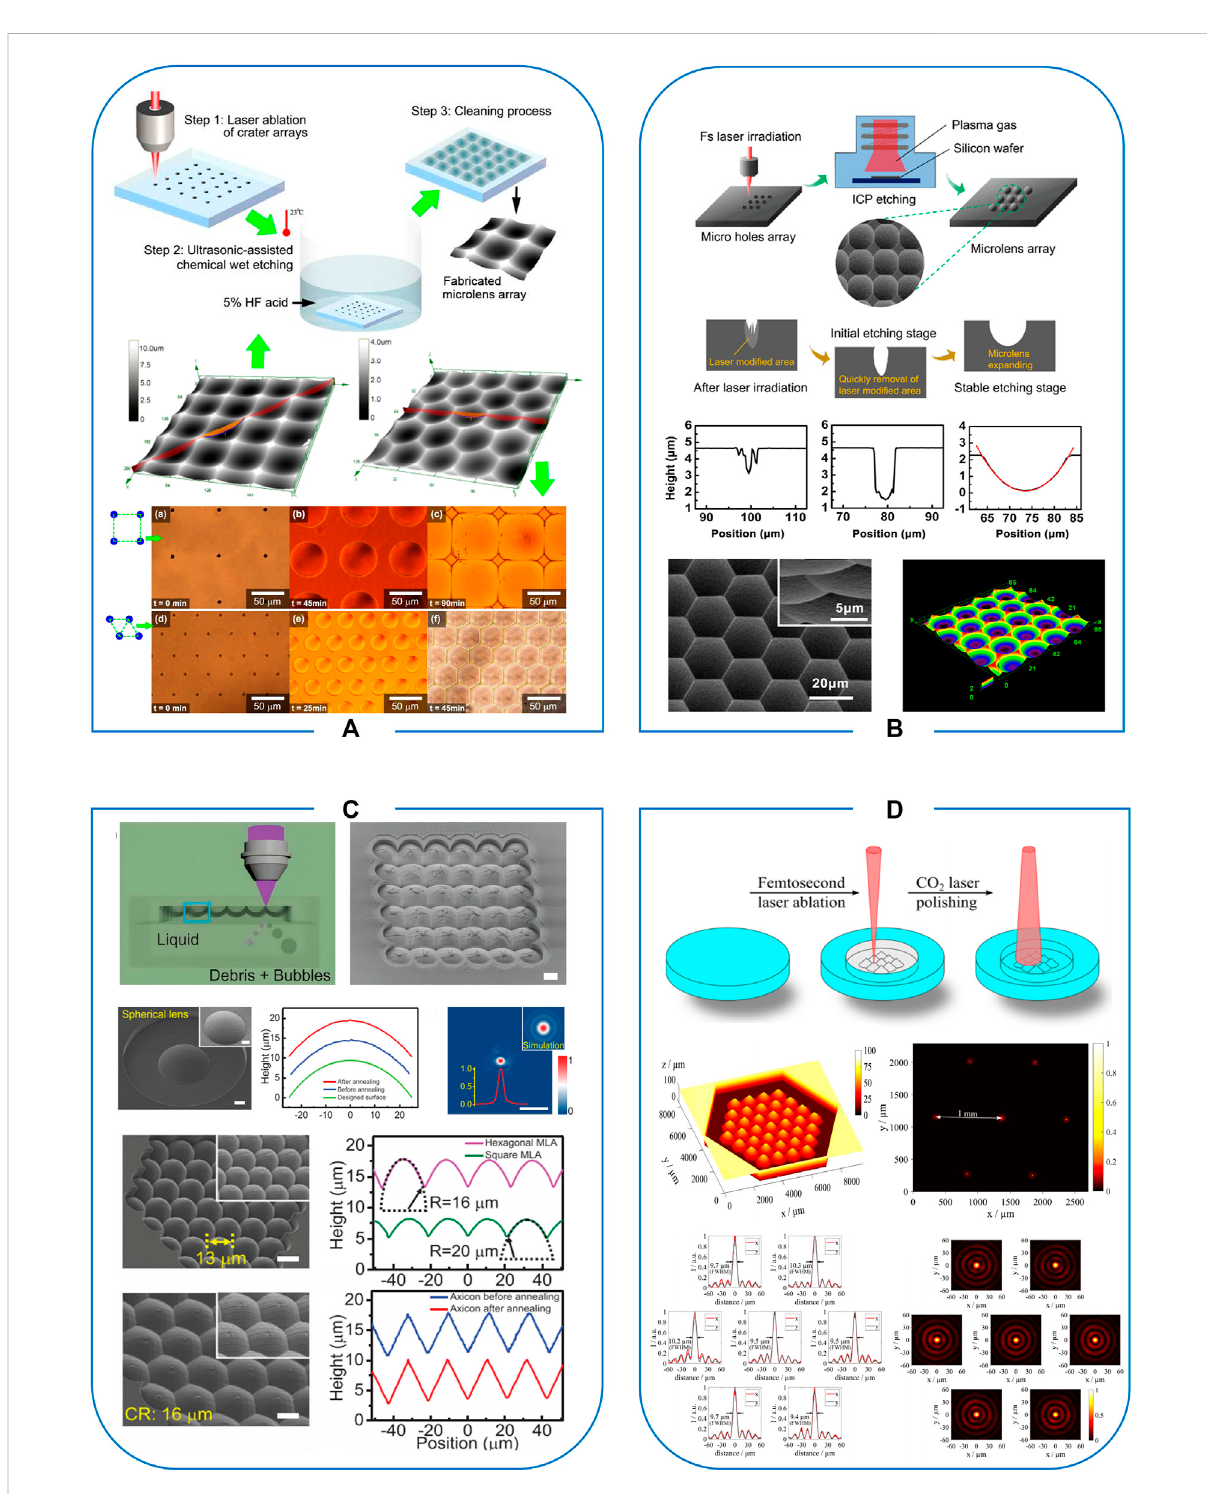
FIGURE 1 (A) Femtosecond laser-assisted wet etching; reproduced with permission from Chen et al. (2010). (B) Femtosecond laser-assisted dry etching; reproducedwithpermissionfromLiuetal.(2017). (C) Liquid-assistedfemtosecondlaserablation;reproducedwithpermissionfromHuaetal.(2022). (D) Femtosecond laser combined with annealing; reproduced with permission from Schwarz et al.